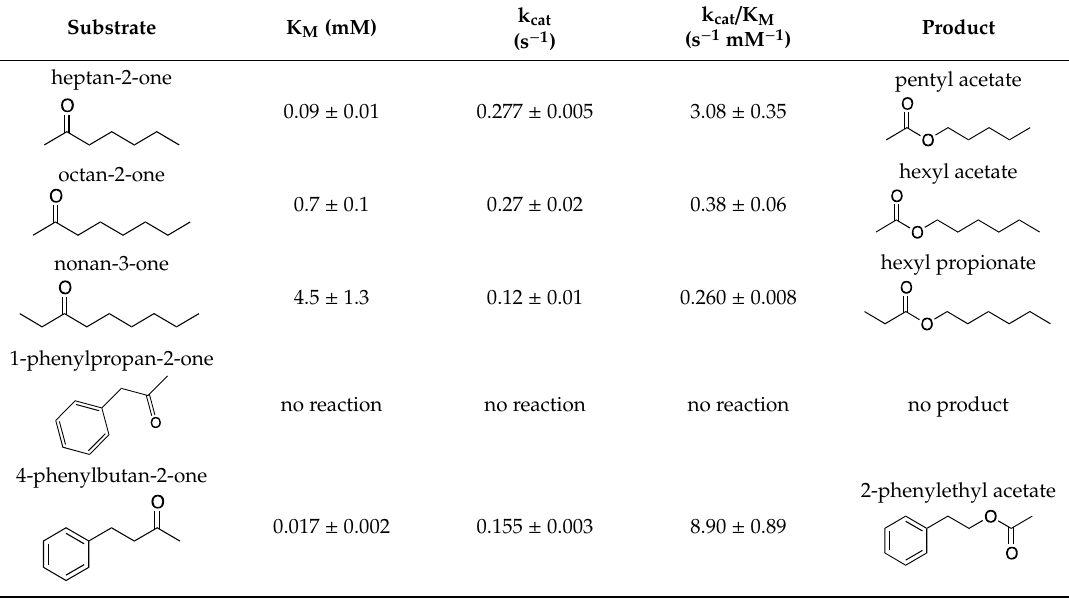
Table 2. Steady-state kinetic analysis of Ht BVMO.